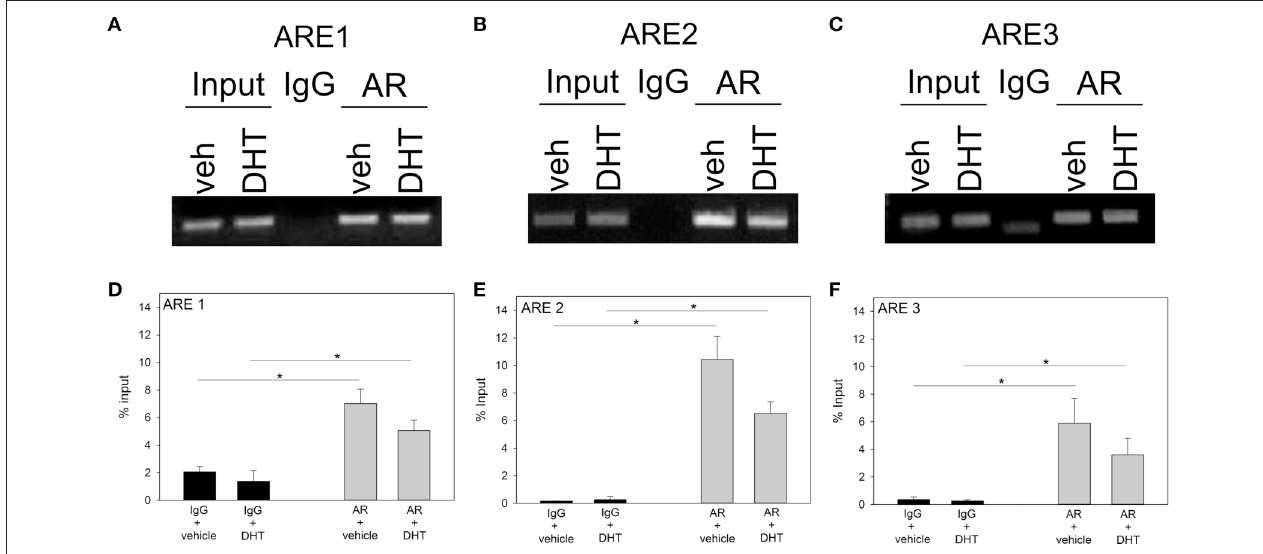
FIGURE 2 | ChIP gel electrophoresis in vehicle (VEH; n = 3 ) or DHT ( n = 3 ) treated GT1-7 neurons (A–C) and qRT-PCR analysis of ARE 1-3 sites (D–F). Using an AR-specific antibody, we found that AR interacts with the ARE 1-3 sites as compared to non-specific IgG immunoprecipitation (* p < 0.05 ). However, DHT-treatment did not enhance AR binding to ARE 1–3